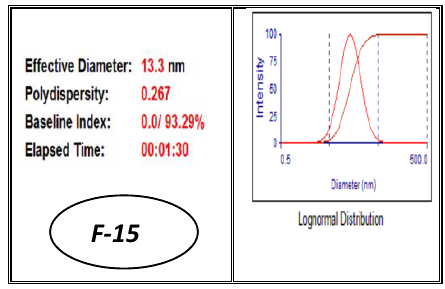
Figure 4. Particle size and polydispersity index for F- 15.